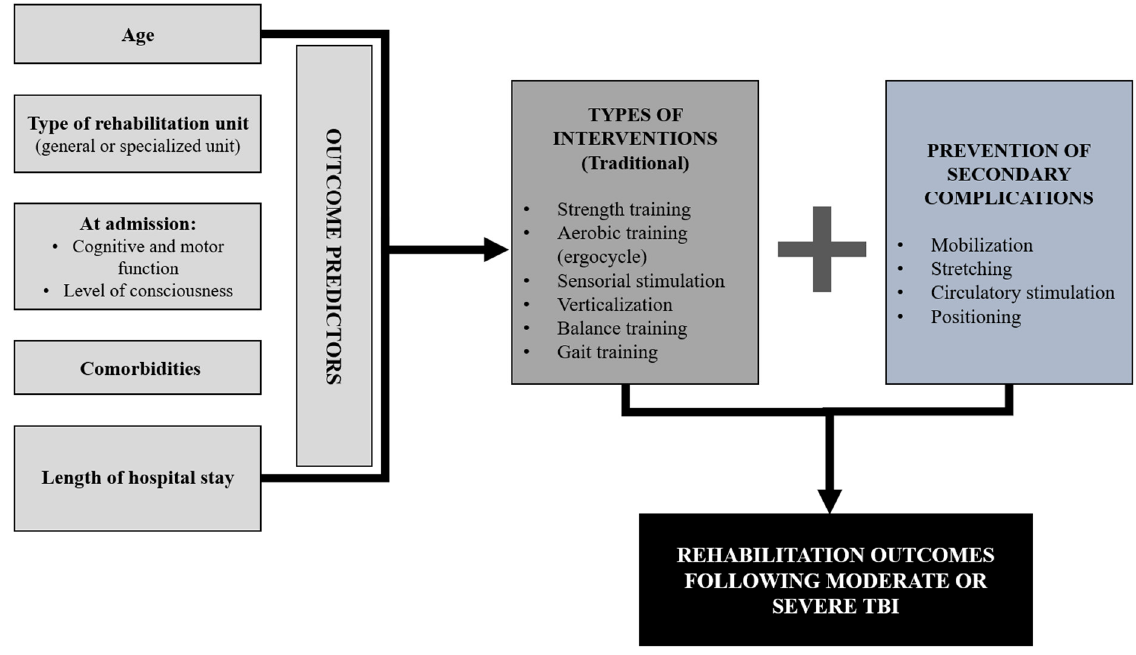
Figure 2. Graphic summary of findings. Table 2. Summary description of the studies included in the review.